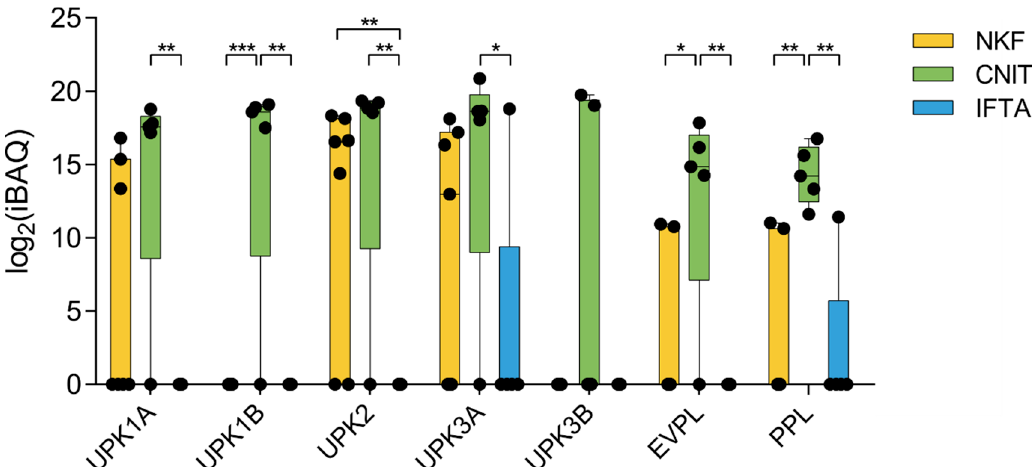
Figure 5. Expression profile of seven proteins of the uroplakin and plakin families. Whiskers represent minimum to maximum; horizontal line represents the mean. UPK1A, uroplakin 1A; UPK1B,